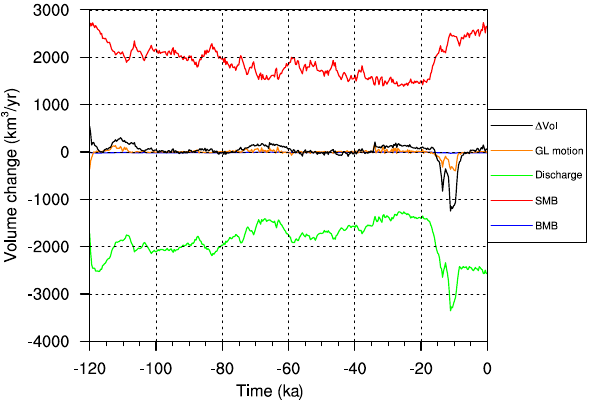
Figure 8. Evolution of the different contributions to grounded ice volume change (in black): Grounding-line motion (orange), ice dis- charge over the grounding line (green), surface mass balance (red) and basal mass balance